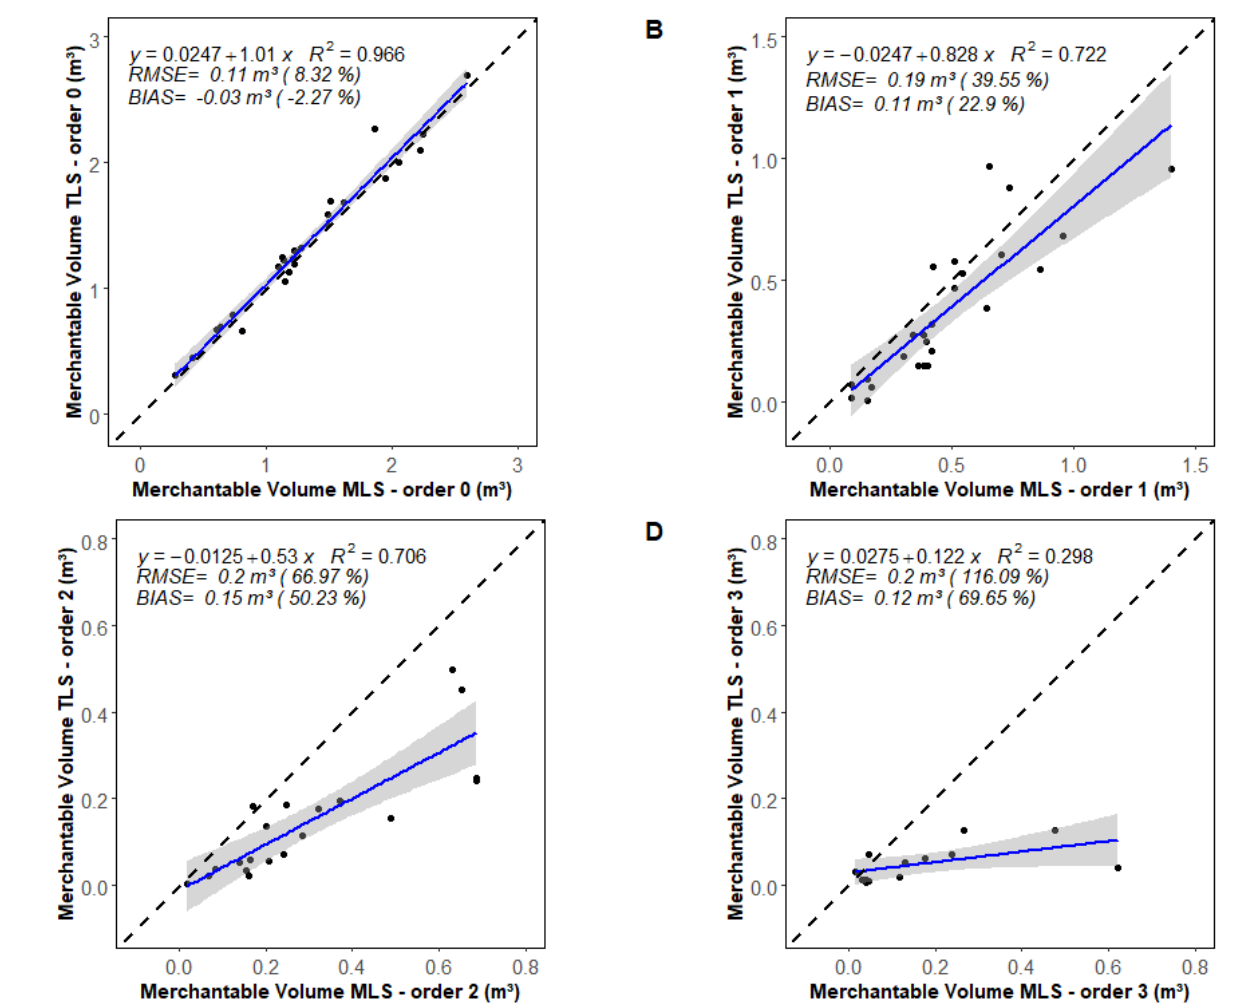
Figure 10. ( A – D ) Comparison of merchantable volume (i.e., stem and branches with small end diameter outside bark (DOB) ≥ 8 cm) derived from TLS and MLS QSMs presented by branching order (with small end DOB ≥ 8 cm): ( A ) order 0 = main stem; ( B ) order 1 = first ‐ level branches; ( C ) order 2 = second ‐ level branches; ( D ) order 3 = third ‐ level branches. n = 26 trees. The blue line represents the linear regression. The grey zone is the 95% confidence band for predictions. The dashed black line represents the 1:1 line.